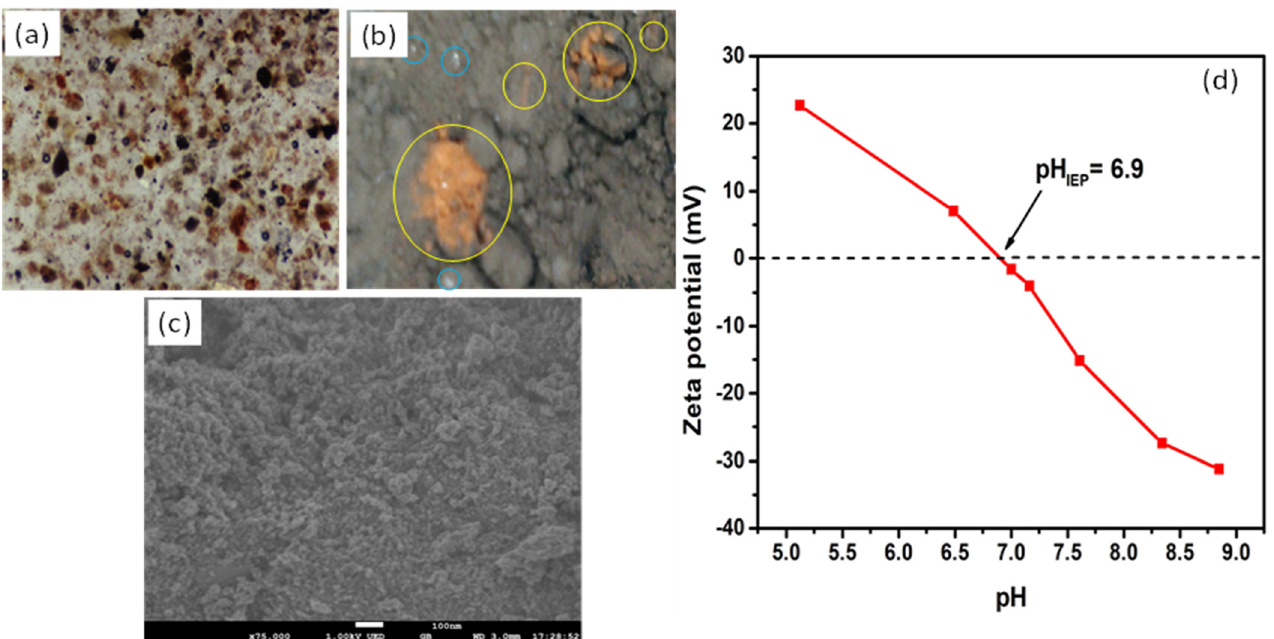
Figure 2. ( a ) and ( b ) Optical micrographs at 500 X of Clay-K and BFS samples, respectively; ( c ) micrograph (SEM) at 75000X of the TiO 2 /Fe 2 O 3 sample. ( d ) Zeta potential of the TiO 2 /Fe 2 O 3 sample as a function of pH. Table 1. Zeta potential, pH IEP , and specific surface area (A BET ) of Clay-K, BFS, and TiO 2 /Fe 2 O 3 materials.